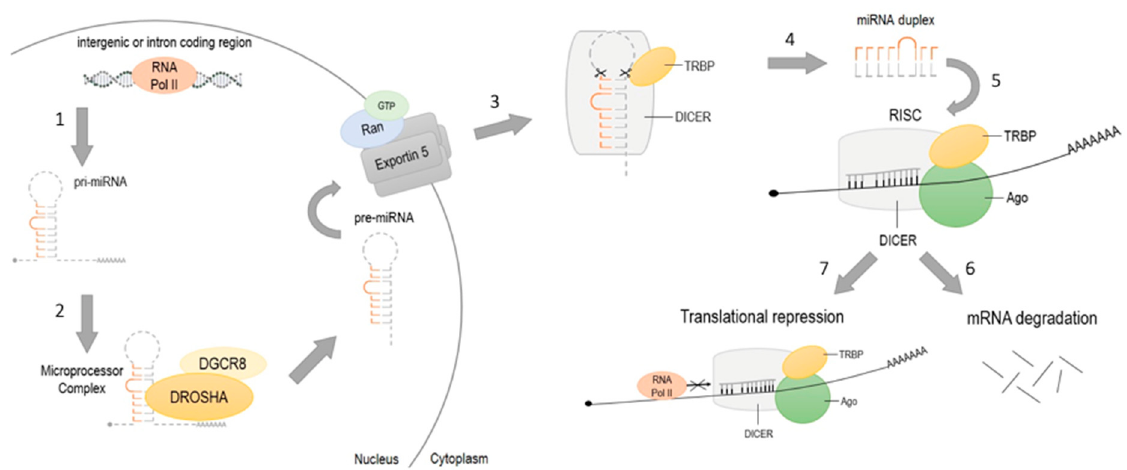
Figure 2. Maturation of miRNA. (1) Transcription of pri-miRNA from intergenic or intron coding regions by RNA polymerase II; (2) recognition of pri-miRNA by DGCR8 and Drosha-cleavage; resulting hairpin- structured pre-miRNA realizing; (3) pre-miRNA transportation from the nucleus to the cytoplasm by Ran/GTP/Exportin 5 complex; (4) pre-miRNA cleavage by Dicer and TAR RNA binding protein (TRBA) to 20–22 nucleotides miRNA; (5) single-stranded miRNA incorporation with Ago and RISC complex connection to target mRNA; gene silencing by (6) translational repression or by (7) mRNA degradation.